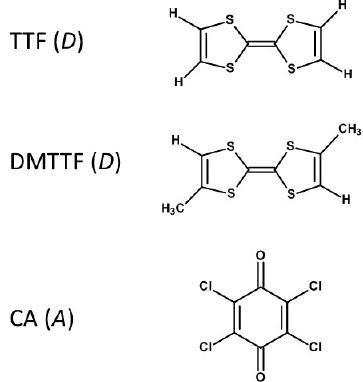
Figure 2. Chemical forms of the donor and the acceptor molecules for the two DA compounds discussed